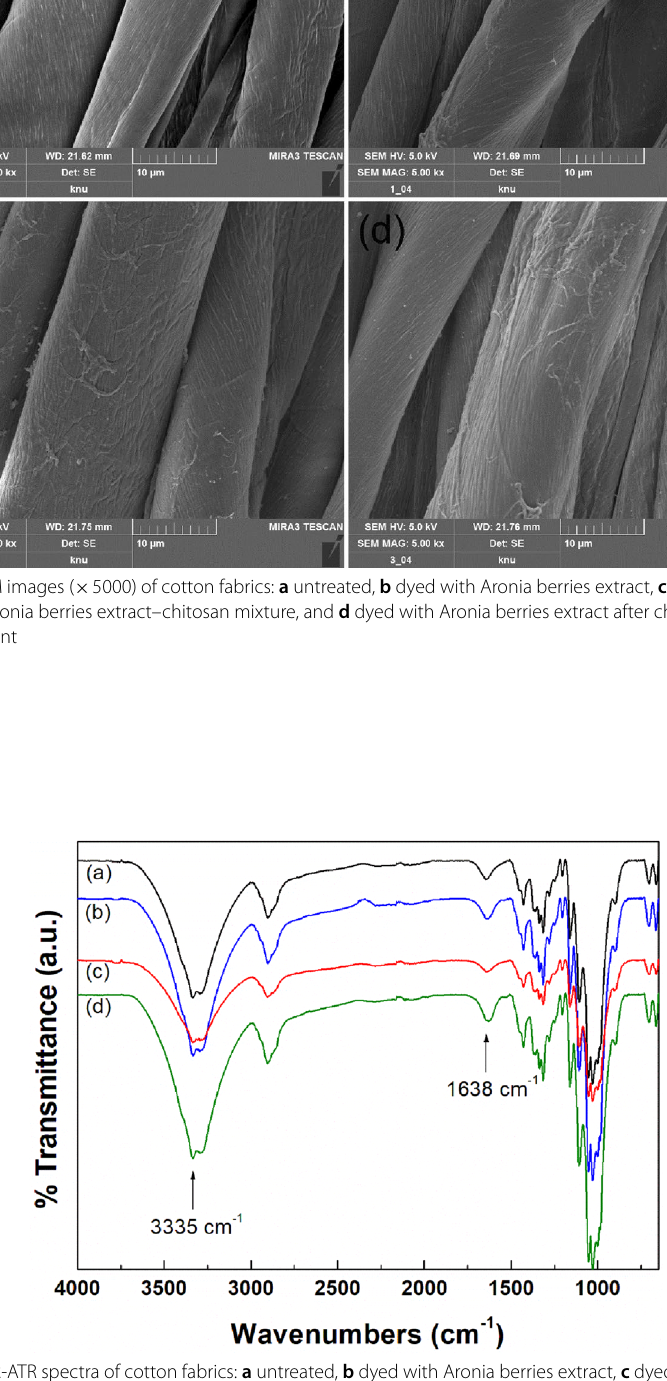
Fig. 6 FTIR‑ATR spectra of cotton fabrics: a untreated, b dyed with Aronia berries extract, c dyed with Aronia berries extract–chitosan mixture, and d dyed with Aronia berries extract after chitosan